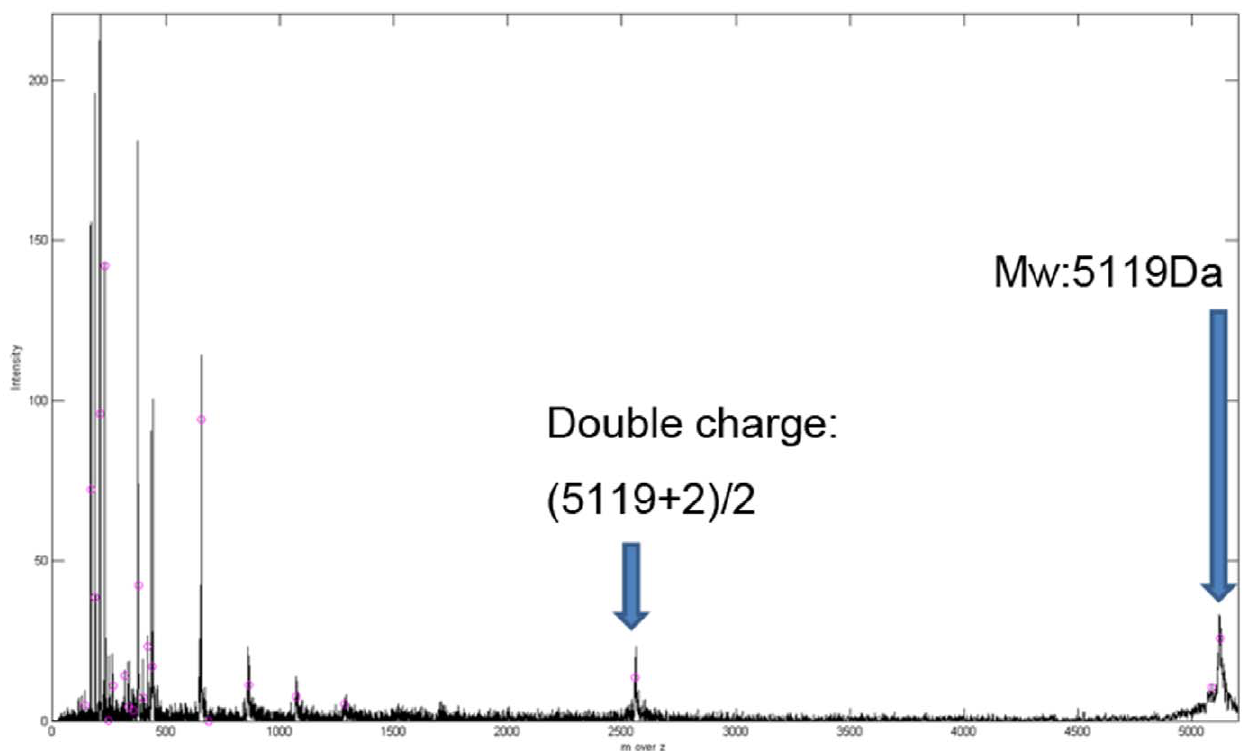
Figure 12. HHTMass on the VrD1 data. HHTMass2 detected the most significant peaks of VrD1, namely the ones at 5119 Da and 2560 Da.